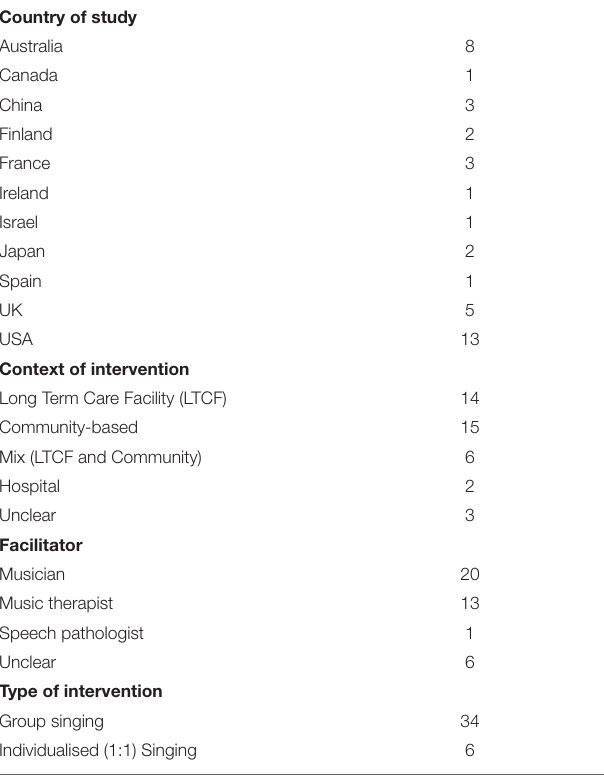
TABLE 2 | Demographic outcomes of included studies. Country of